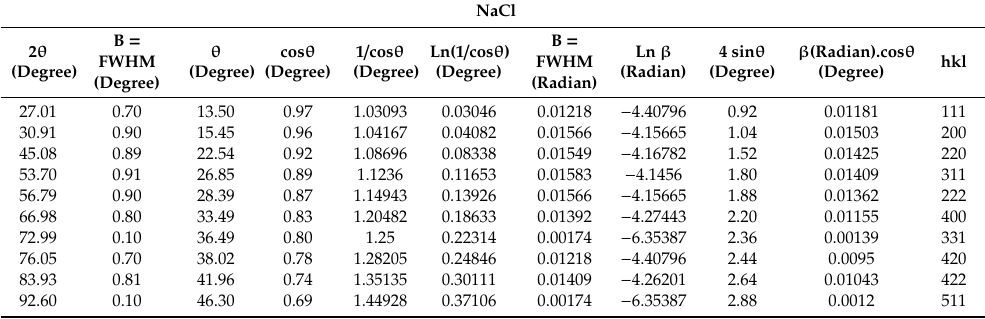
Table 5. Crystallographic parameters of each individual XRD pattern related to